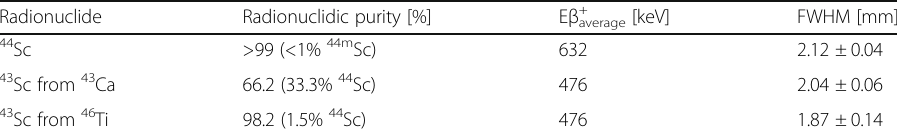
Table 4 FWHM determined for phantom hole-diameters of 1.3 mm for 44 Sc and 43 Sc in three dif- ferent sections of the PET scan